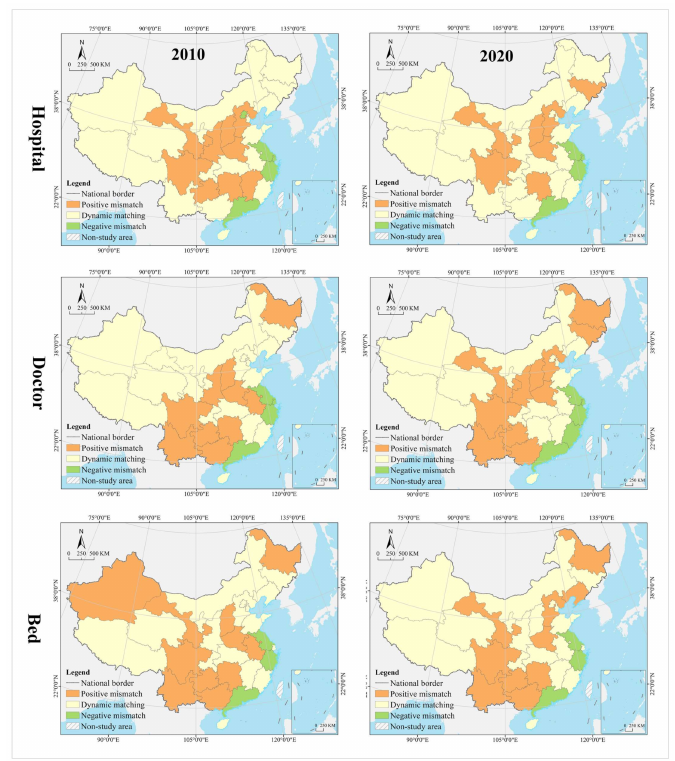
Figure 11. Spatial clustering analysis of mismatch type for